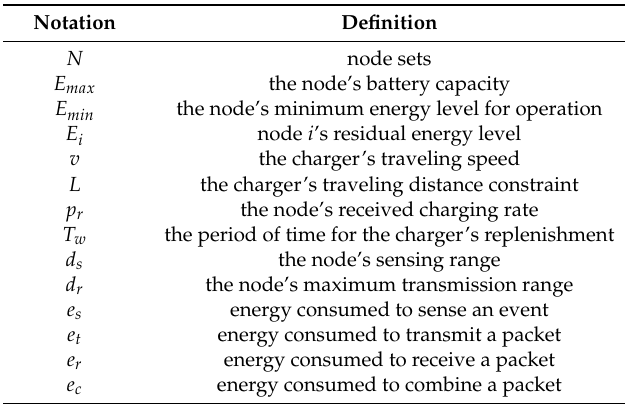
Table 1. List of